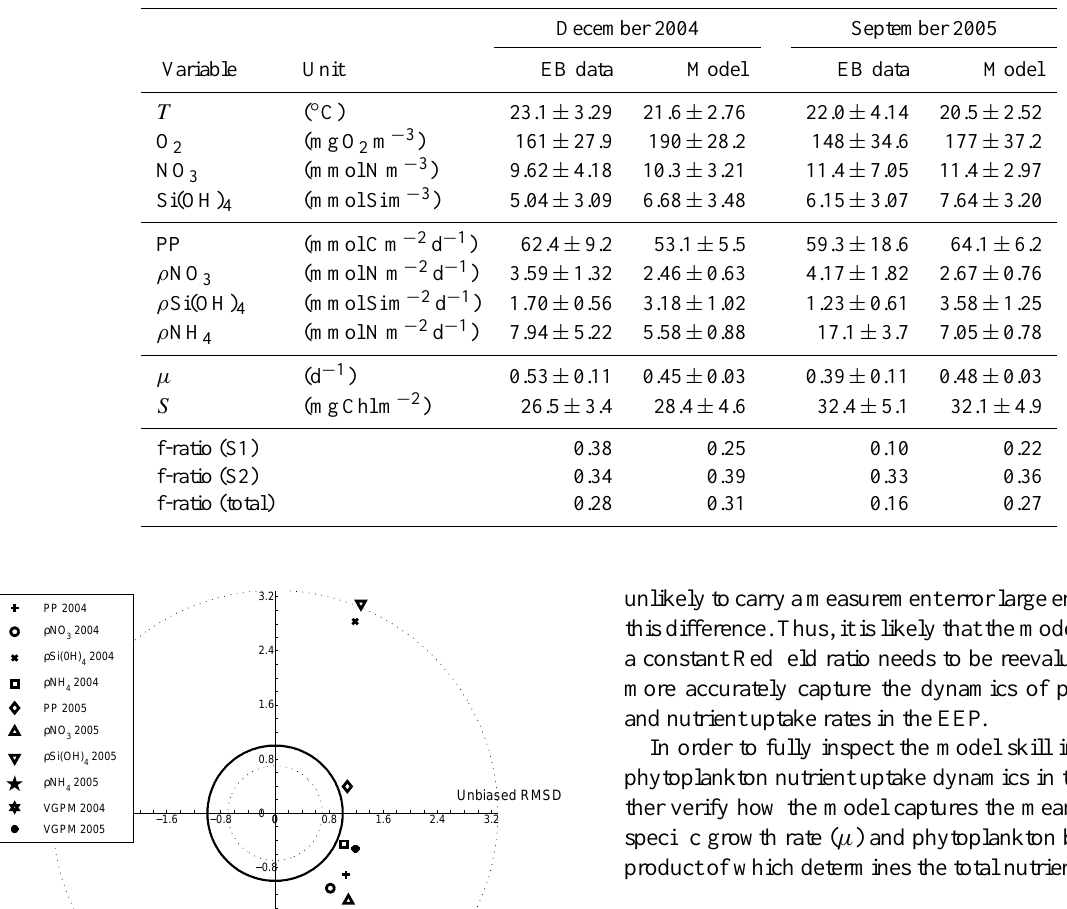
Table 2. The 2004–2005 model–data comparison of monthly and domain average (1 ◦ S–1 ◦ N and 140 ◦ W–110 ◦ W) hydrographic conditions ( T , O 2 , NO 3 , Si(OH) 4 ), depth-integrated total phytoplankton nutrient ( ρ NO 3 , ρ NH 4 , ρ Si(OH) 4 ) and C (PP) uptake rates, total phytoplankton specific growth rates ( µ ) and biomass ( S ), as well as total and size-fractionated f -ratios. Mean and standard deviations come from the along- equatorial profiles between 140 ◦ W and 110 ◦ W. PP data from Balch et al. (2011), ρ NO 3 and ρ NH 4 from Parker et al. (2011), and ρ Si(OH) 4 from Krause et al. (2011), µ data from Selph et al. (2011) and biomass estimates from Balch et al. (2011). Cruise f-ratios were calculated by Parker et al. (2011). Depth integration is over the top 75m depth, beneath which there is little nutrient uptake by phytoplankton (Aufdenkampe et al., 2002; Parker et al., 2011).